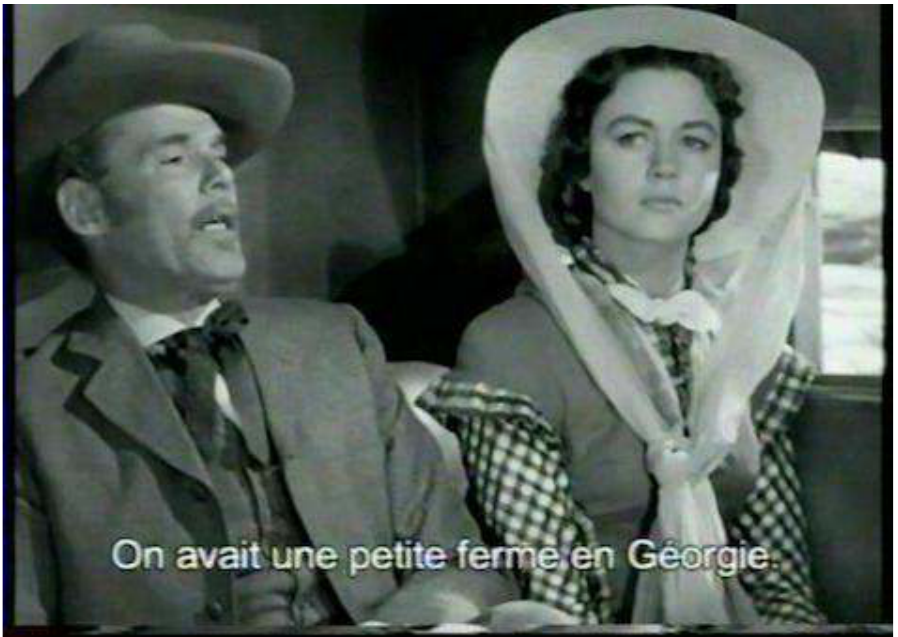
Figure 13: The Winslows going west in Colorado